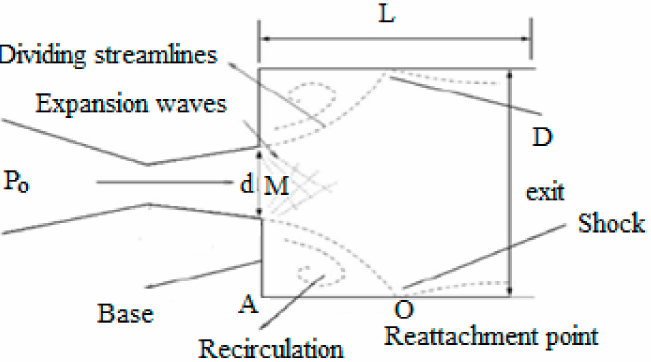
Figure 1. Suddenly expanded flow field, with duct diameter (D) and nozzle exit diameter